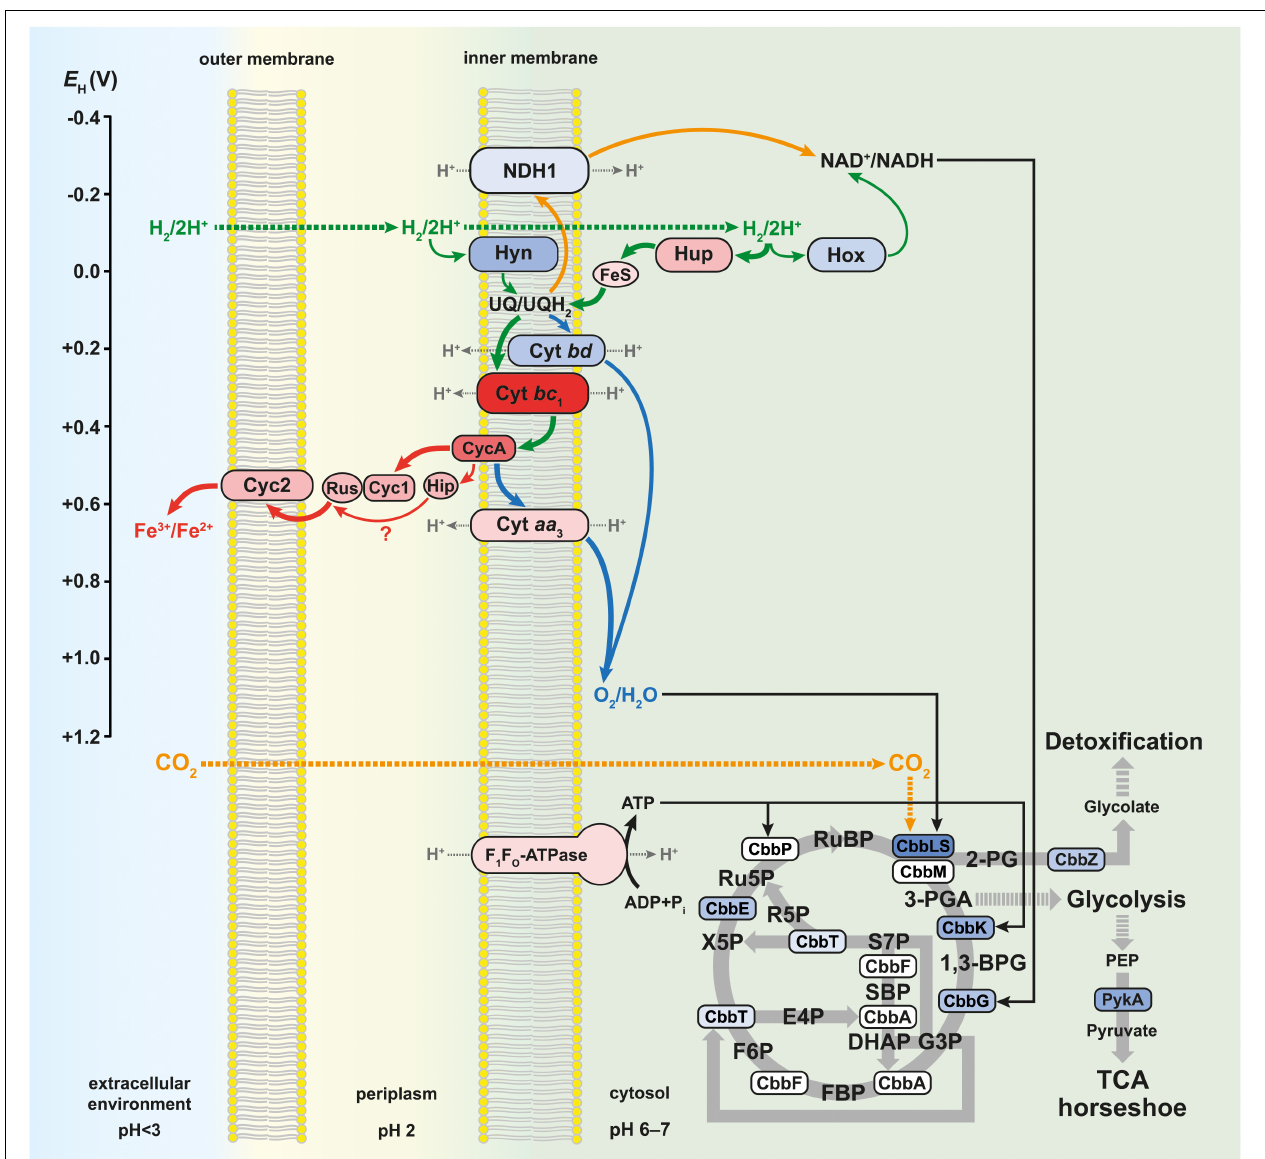
FIGURE 4 | Model of aerobic and anaerobic metabolism of hydrogen connected with carbon dioxide assimilation in At. ferrooxidans . Solid green arrows indicate direct electron transfer, solid orange arrows indicate reverse electron transfer, and solid gray arrows indicate enzymatic reactions during the aerobic and anaerobic metabolism. Solid blue arrows indicate direct electron transfer during aerobic metabolism, while solid red arrows indicate direct electron transfer during anaerobic metabolism. The thickness of the colored arrows corresponds to the pathway significance according to the relative protein abundance in Figure 3 . Dotted gray arrows indicate proton transfer, dotted green arrows indicate hydrogen influx, and dotted orange arrows indicate carbon dioxide influx. The color of proteins and multiprotein complexes corresponds to the log 2 fold changes in Figure 2 . The redox potential values ( E H ) for individual proteins and multiprotein complexes are referenced in the text. 2-PG, 2-phosphoglycolate; 3-PGA, 3-phosphoglycerate; 1,3-BPG, 1,3-bisphosphoglycerate; G3P, glyceraldehyde 3-phosphate; DHAP, dihydroxyacetone phosphate; SBP, sedoheptulose 1,7-bisphosphate; S7P, sedoheptulose 7-phosphate; E4P, erythrose 4-phosphate; FBP, fructose 1,6-bisphosphate; F6P, fructose 6-phosphate; R5P, ribose 5-phosphate; X5P, xylulose 5-phosphate; Ru5P, ribulose 5-phosphate; RuBP, ribulose 1,5-bisphosphate; PEP, 2-phosphoenolpyruvate; TCA, tricarboxylic